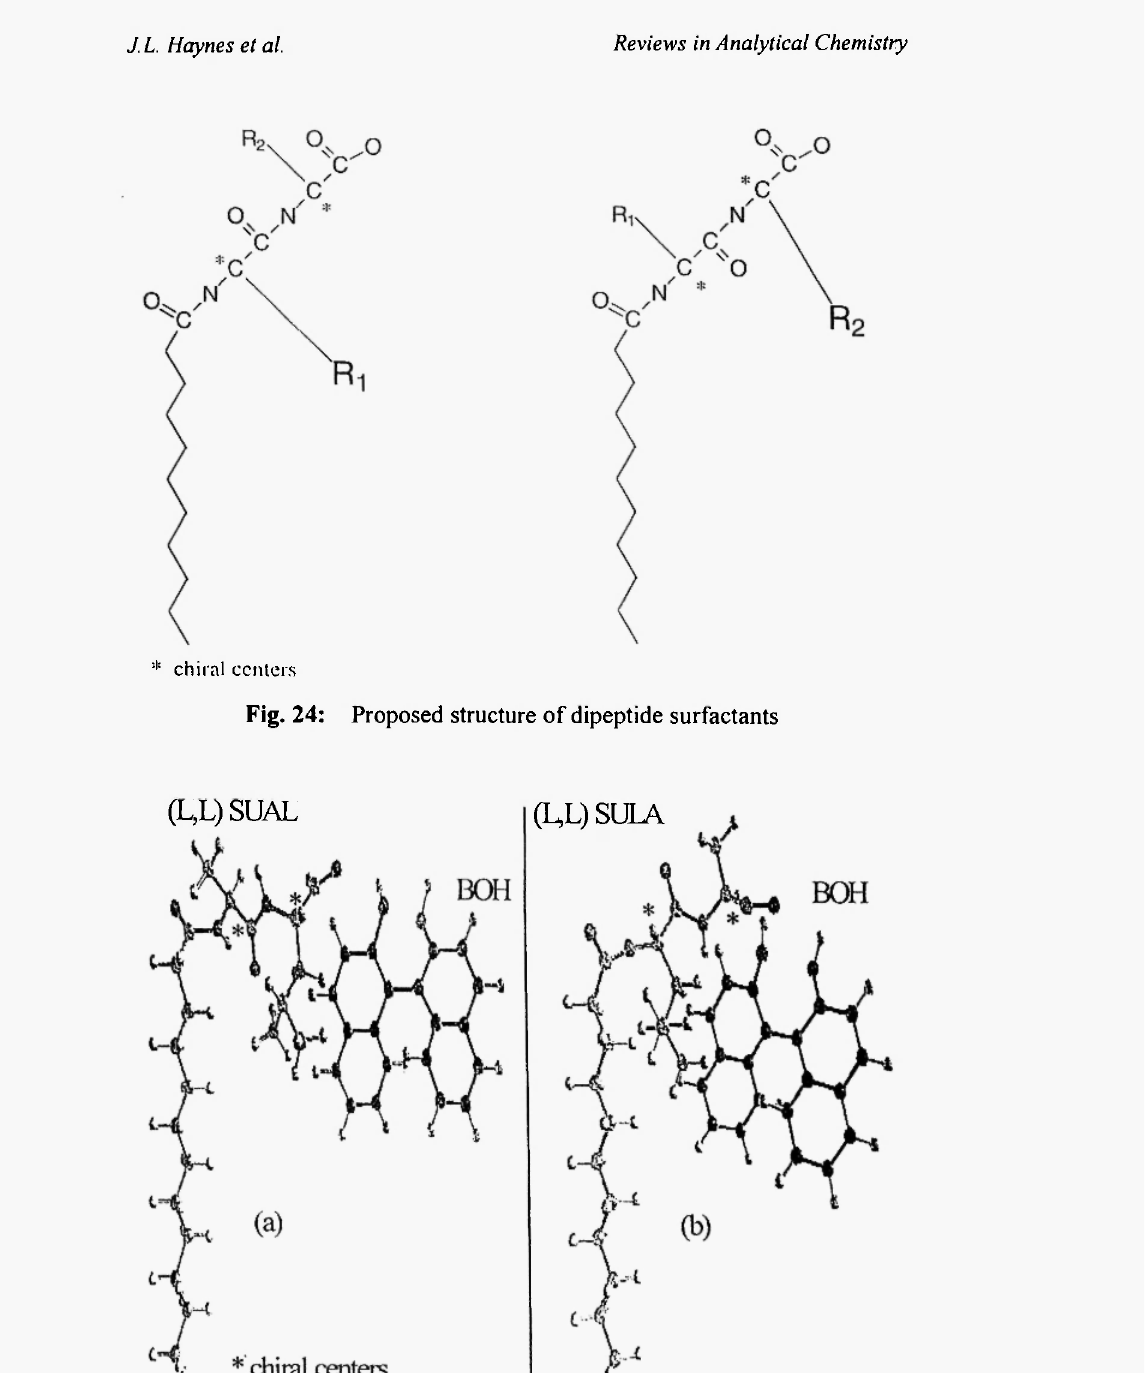
Fig. 25: Proposed interaction between (±)-BOH with poly-L-SUAL and poly-L-SULA. From 764/ with